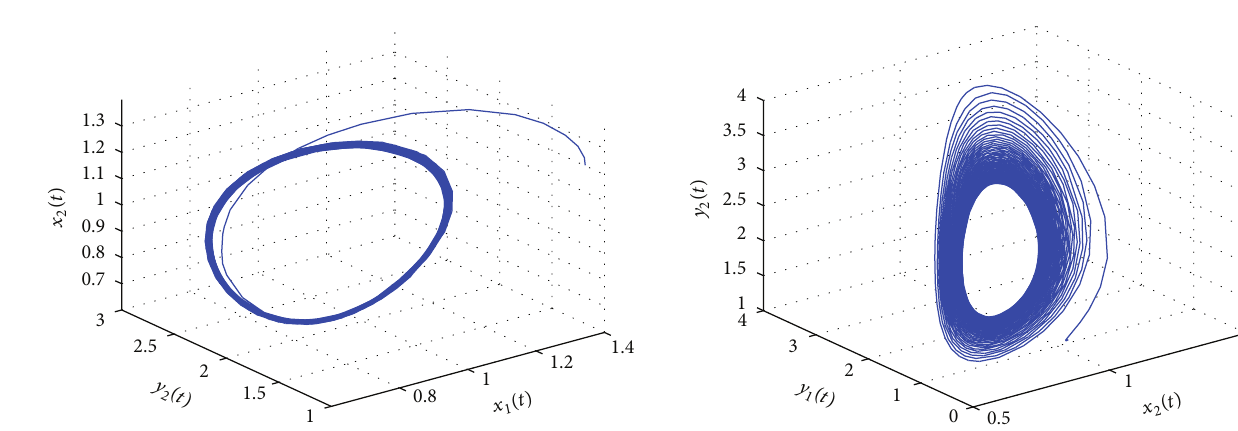
Figure 6: The phase plot of the states 𝑥 2 , 𝑦 1 , 𝑦 2 for 𝜏 1 = 4.71500 > = 4.5061 𝜏 10